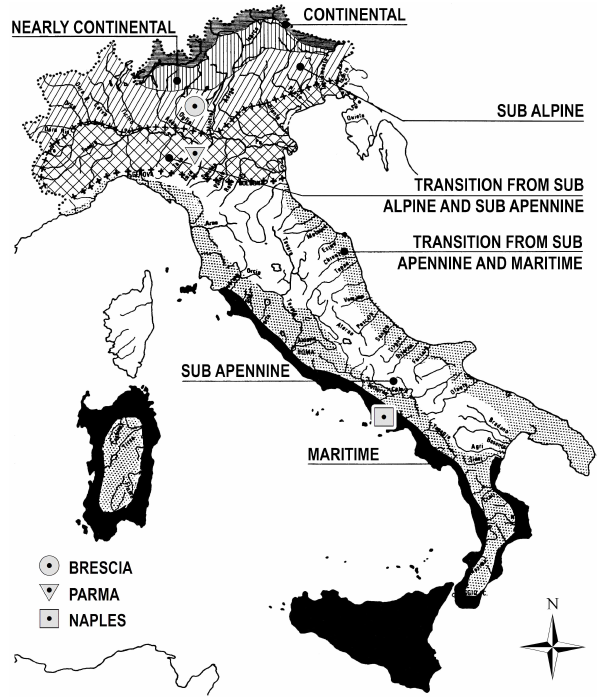
Fig. 1. Italian precipitation regimes and raingauge locations (re- drawn from Moisello,